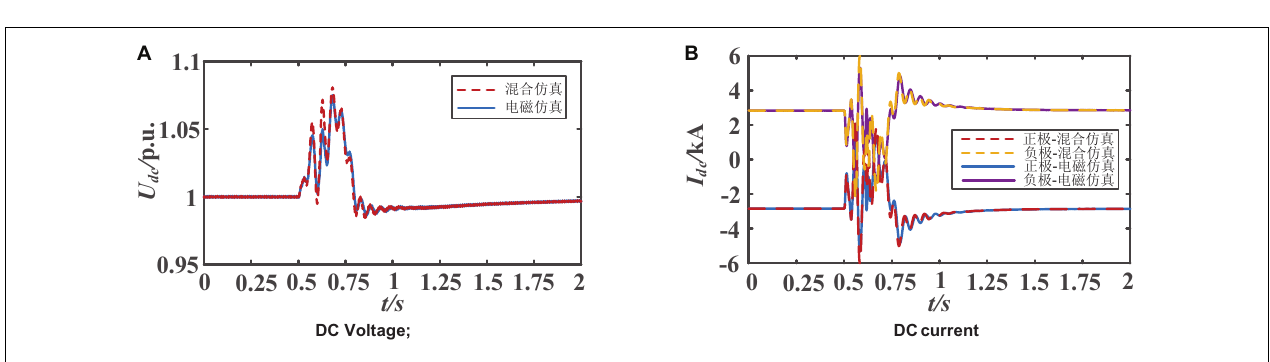
FIGURE 12 | Dynamic characteristics of Zhangbei station; (A) DC Voltage; (B) DC current.